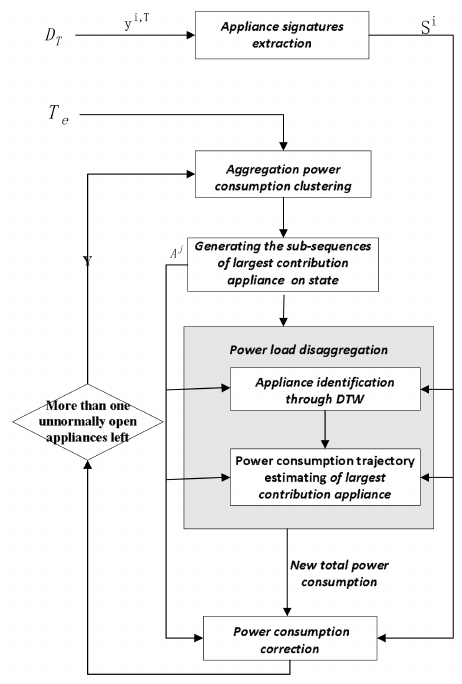
Figure 2. The flowchart of the algorithm proposed in this paper. DTW: Dynamic Time Warping.